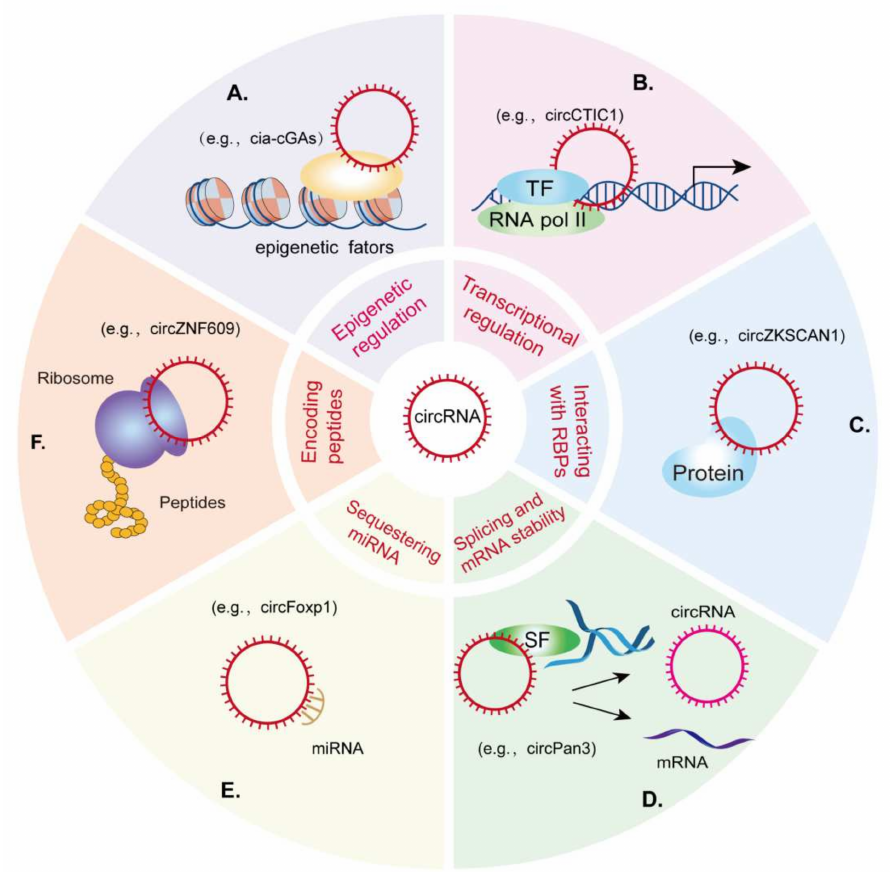
Figure 1. Molecular mechanisms of circRNA functions. circRNAs are involved in ( A ) epigenetic regulation, ( B ) transcriptional regulation, ( C ) protein interactions, ( D ) the regulation of splicing, ( E ) functioning as miRNA sponges, and ( F ) encoding